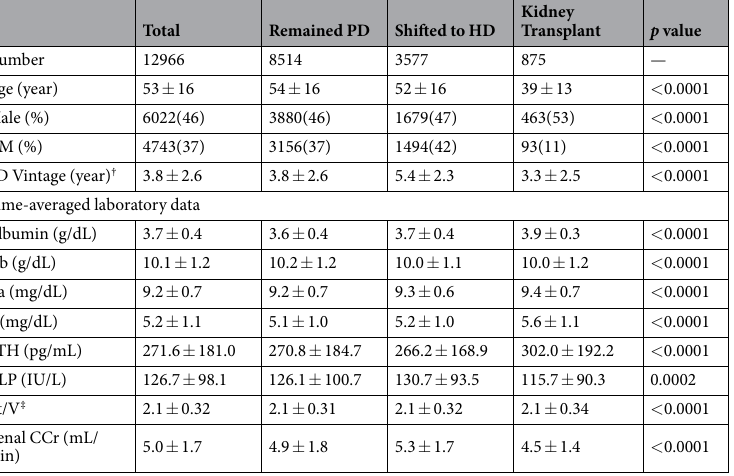
Table 1. Demographic characteristics and time-averaged laboratory data of the entire PD population in Taiwan from 2005 to 2012. PD, peritoneal dialysis; HD, hemodialysis; DM, diabetes mellitus; Hb, Hemoglobin; Ca, serum total calicium; P, serum phosphorus; PTH, parathyroid hormone; ALP, total alkaline phosphatase; Renal CCr, renal creatinine clearance. † PD vintage of each patient was calculated from the start of 2005 to termination of PD or the end of 2012. ‡ Weekly Kt/V, including renal